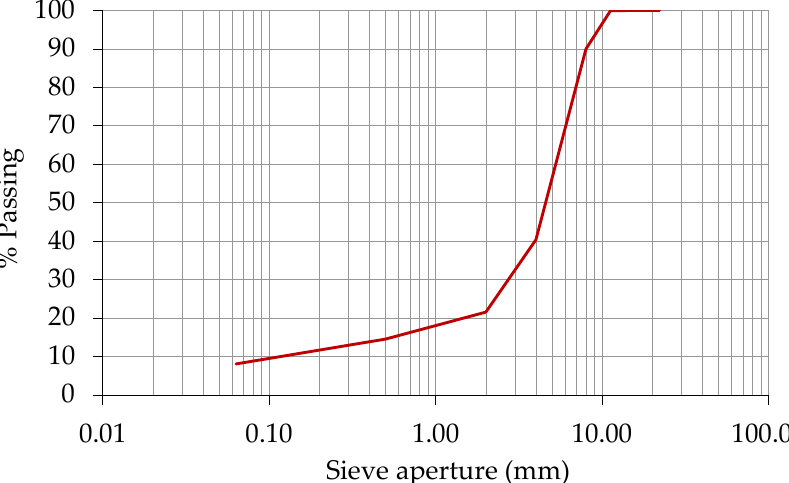
Figure 1. Particle size distribution.